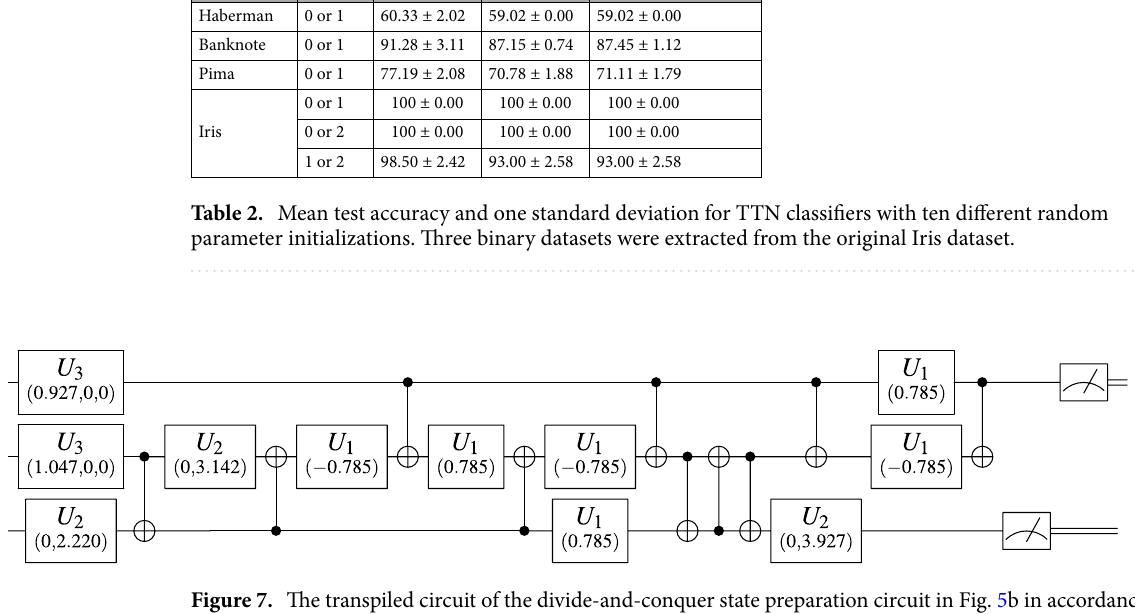
Figure 7. The transpiled circuit of the divide-and-conquer state preparation circuit in Fig. 5b in accordance with the physical qubit layout of the ibmq_rome device. The gates U 1 , U 2 , and U 3 are physical single-qubit gates of IBM Quantum Experience that take in one, two, and three parameters, respectively. The measurement outcomes are stored in classical registers denoted by c [0] and c